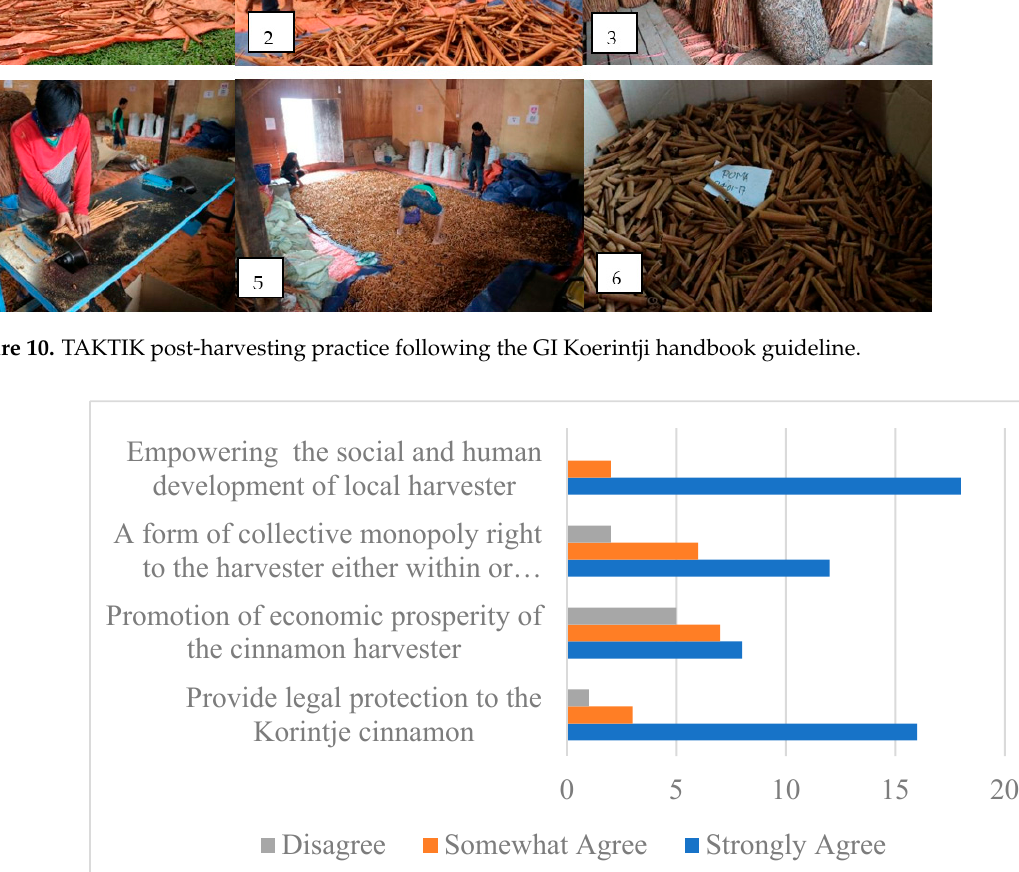
Figure 11. The function of GI for TAKTIK members.